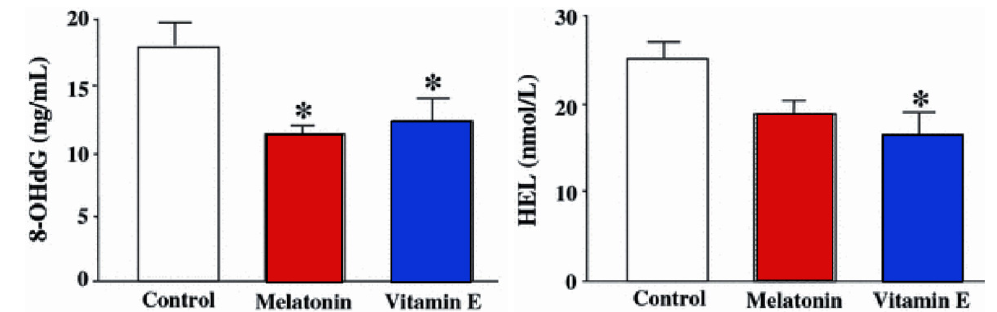
Figure 5. Mean (±SEM) 8-OHdG (8-hydroxy-2-deoxyguanosine; a product of oxidatively damaged DNA) and HEL (hexanoyl-lysine adduct; a product of oxidatively damaged lipid) levels in the follicular fluid of women treated with melatonin (3 mg daily) or vitamin E (600 mg daily) for 37 days. Both antioxidants obviously reduced free radical damage; however, even though the dose of melatonin was 200 times less than that of vitamin E, it proved as effective in reducing free radical damage to the oocytes. * p < 0.05 compared to control values. Modified from Tamura et al. [96].